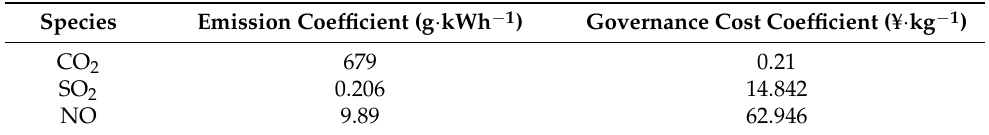
Table 2. Pollutant emissions and charges of diesel generators